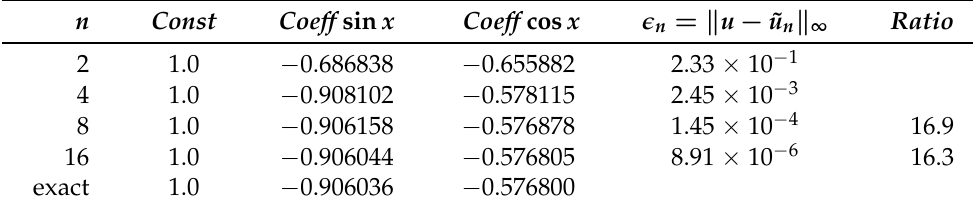
Table 2. IE (42). QM: Simpson’s rule.